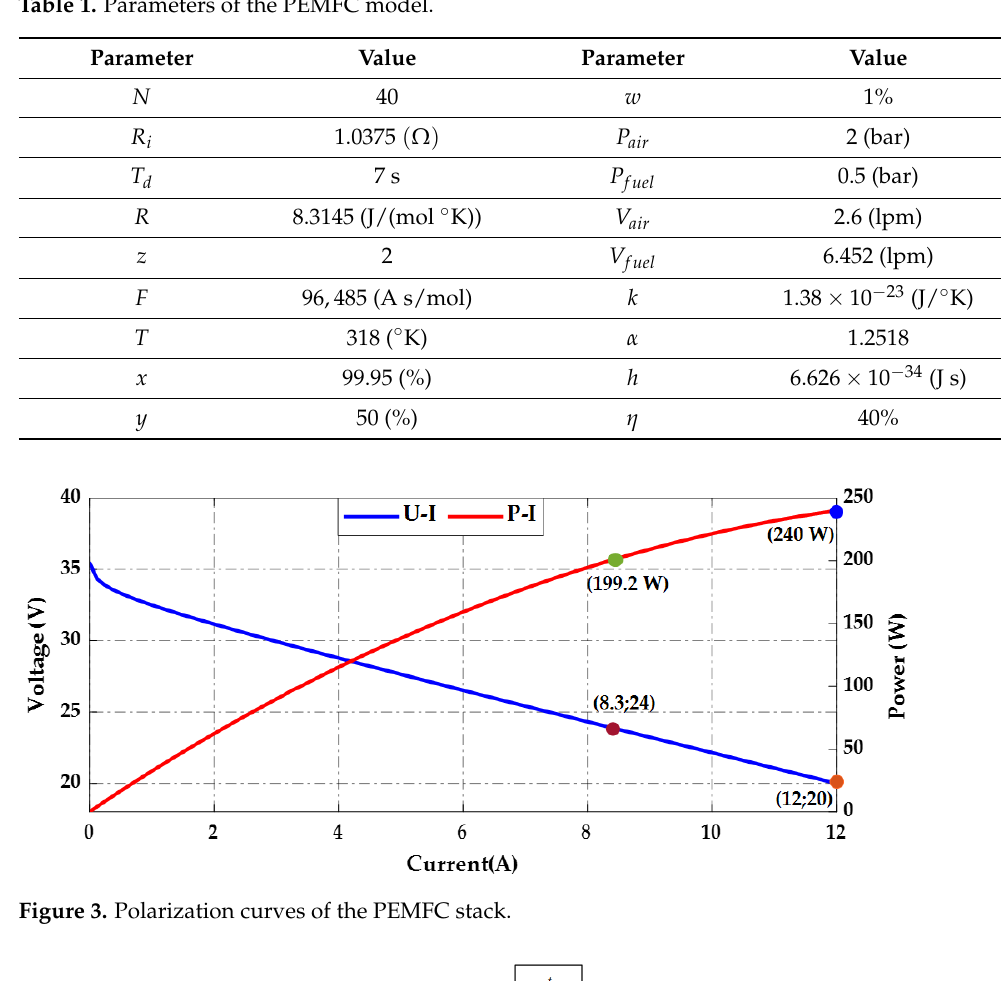
Table 1. Parameters of the PEMFC model.